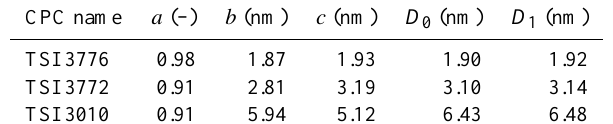
Table A1. Fitting parameters of Eq. (A1) and retrieved D 0 , D 1 for the three TSI CPCs of the CPC battery.